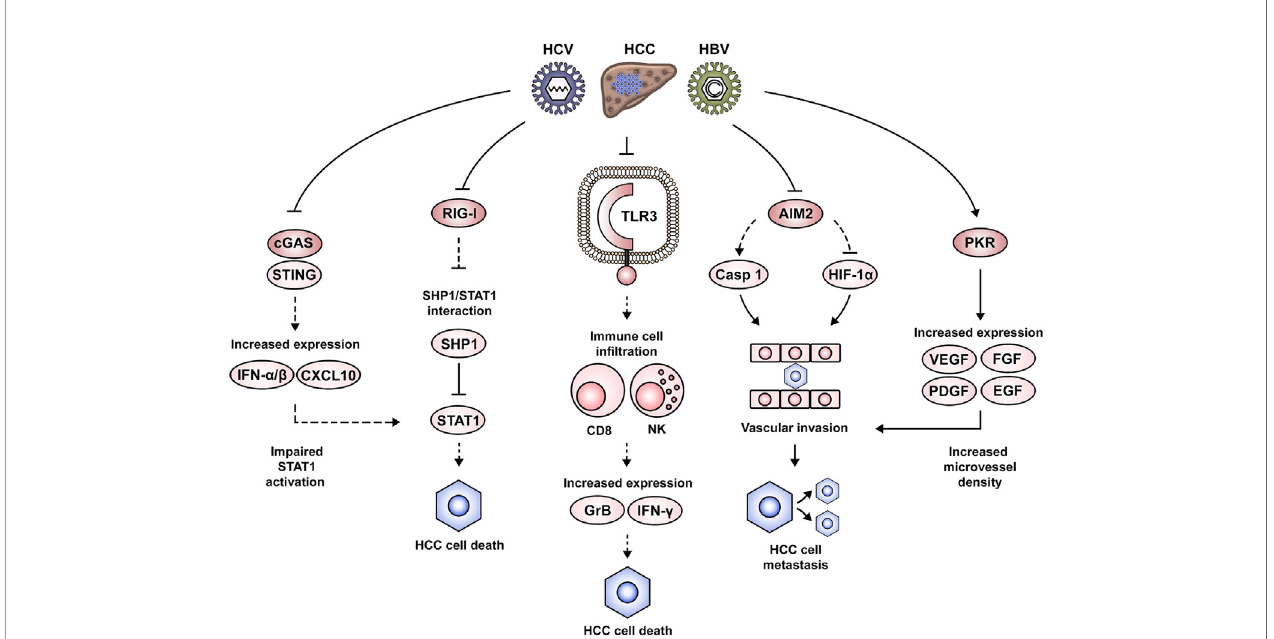
FIGURE 3 | Dysregulation of nucleic acid-induced signaling during HCC development. Altered nucleic acid-sensing pathways associated with HCC pathogenesis include cGAS/STING, RIG-I, TLR3, AIM2 and PKR. Impairment of RIG-I expression favors STAT1 interaction with its negative regulator SHP1, thus altering STAT1- mediated proapoptotic signaling. Similarly, the suppression of IFN signaling via the cGAS/STING pathway leads to an altered STAT1 activation. Downregulation of TLR3 in the context of HCC leads to an impaired attraction/activation of immune cells to the tumor microenvironment, the failure to induce a gene expression pattern that mediates cytotoxicity (e.g., GrB, IFN- g ) and the subsequent clearance of cancer cells. AIM2 downregulation alters normal formation of the AIM2 in fl ammasome and favors expression of HIF-1 a , leading to the development of malignant cellular characteristics such as vascular invasion and lymph node metastasis. Activation of PKR in tumor lesions favors the expression of growth factors such as VEGF, PDGF, FGF, and EGF, which favor angiogenesis and potentially the development of vascular invasion and